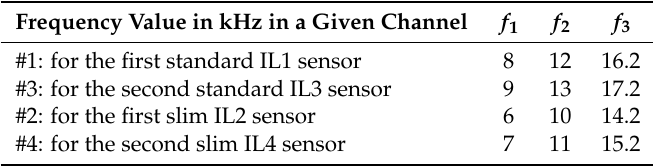
Table 4. The list of excitation frequencies applied in the system.